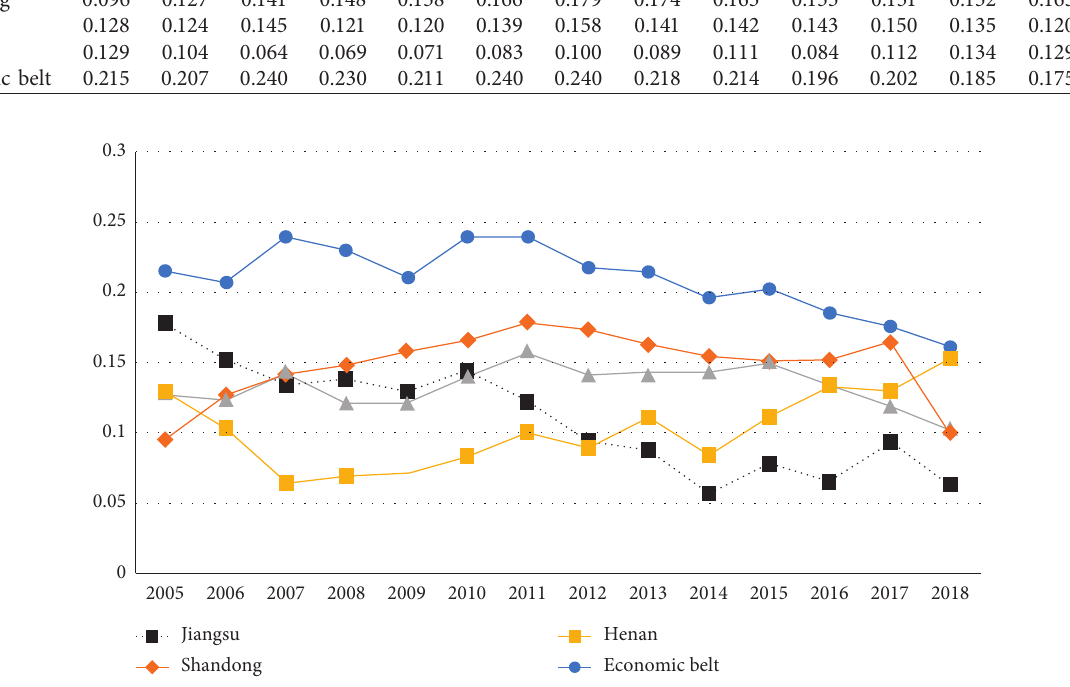
Figure 8: Value trend of comprehensive competitiveness of cities in Huaihe eco-economic belt from 2005 to